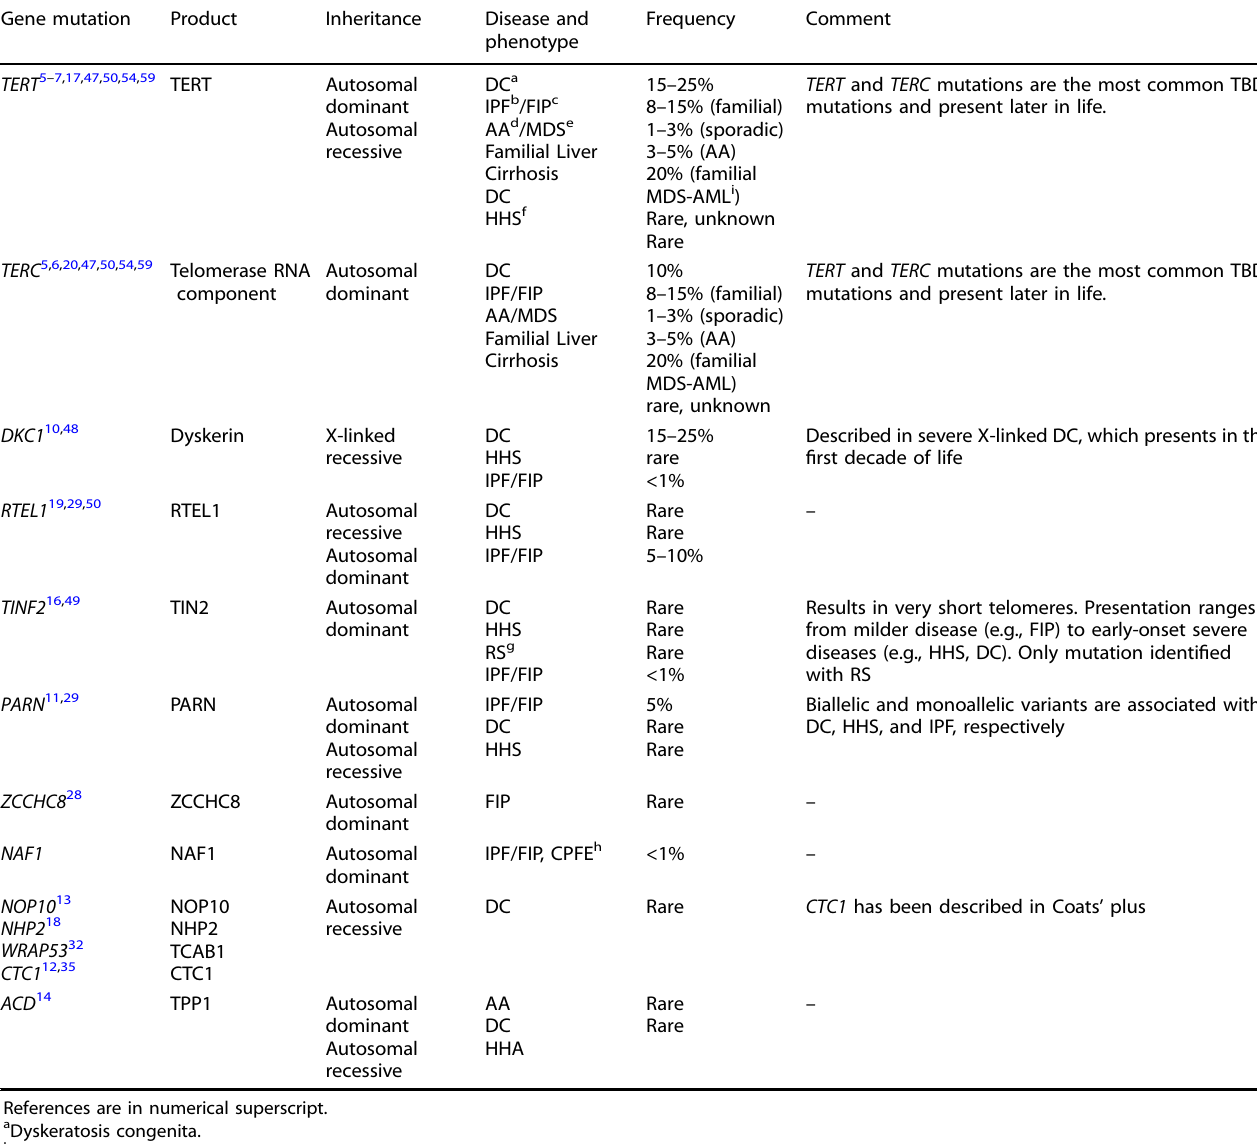
Table 1. Summary of genetic mutations described in telomere biology